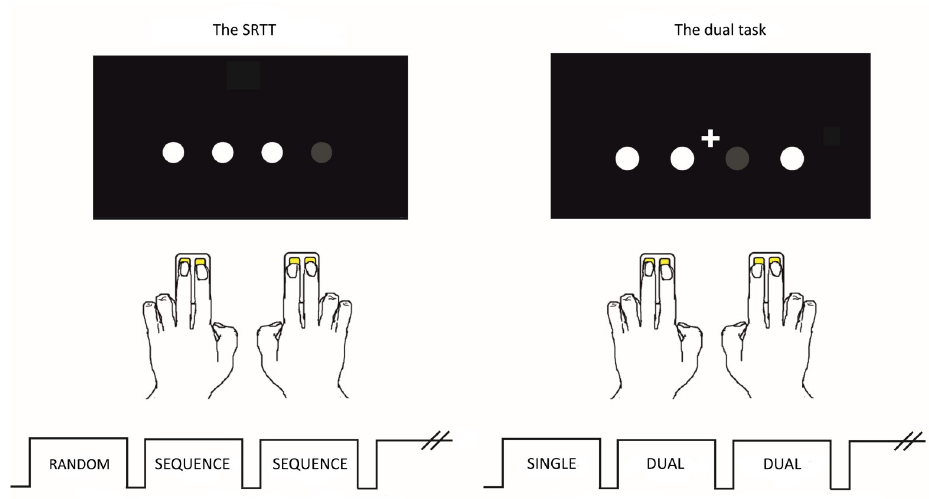
Fig 1. Set-up of the SRTT and the dual task. Left: The SRTT. Interleaved random and sequence blocks. The differences in reaction time and percent accuracy between the last two random blocks and the last two implicit blocks, evaluated before and after a break, were used as measures of implicit sequence learning. Right: The dual task. Interleaved single and dual task blocks. The differences in reaction time and percent accuracy between the single blocks and the dual blocks as well the performance of correctly counting the plus signs, were used as measures of dual task ability. For the SRTT, four white circles on a horizontal line were shown on a black screen and each circle’s position corresponded to one of the four buttons of the two response pads. Every 1.2 seconds, one of the circles turned grey and the participants were to press the corresponding button as quickly as possible. The SRTT consisted of 19 blocks of 40 trials each, and all blocks were followed by a six second break. Unbeknownst to the participants, in 12 of the 19 blocks the trials followed a 10–item higher (second) order sequence (1 3 1 2 4 3 2 4 1 3), from here on referred to as sequence blocks. Participants were exposed to the sequence 48 times (24 times